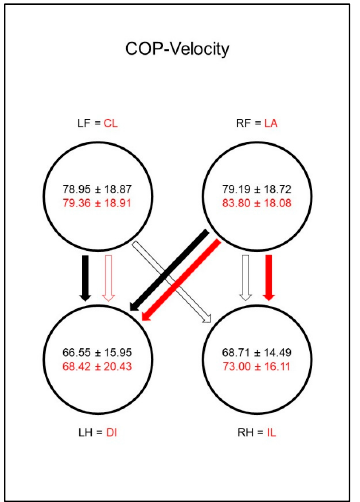
Figure 18. Speed of center of pressure movement in millimeters per second (COP-Velocity, mm/s) in study group 2 and control group. For detailed explanation and abbreviations refer to Figure 2. The situation was different with the COP-Radius% (Figure 19). While in sound animals the radius of the COP did not differ between the limbs, in diseased animals there was a relative reduction in the contralateral front limb with a simultaneous relative increase in the other three limbs. This resulted in a significantly lower radius in the contralateral front limb compared to the other three limbs. However, no difference could be shown between the groups.